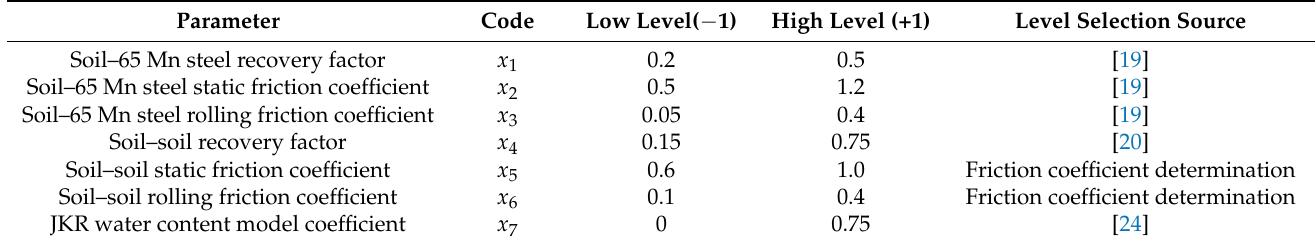
Table 5. Plackett–Burman test factor codes.